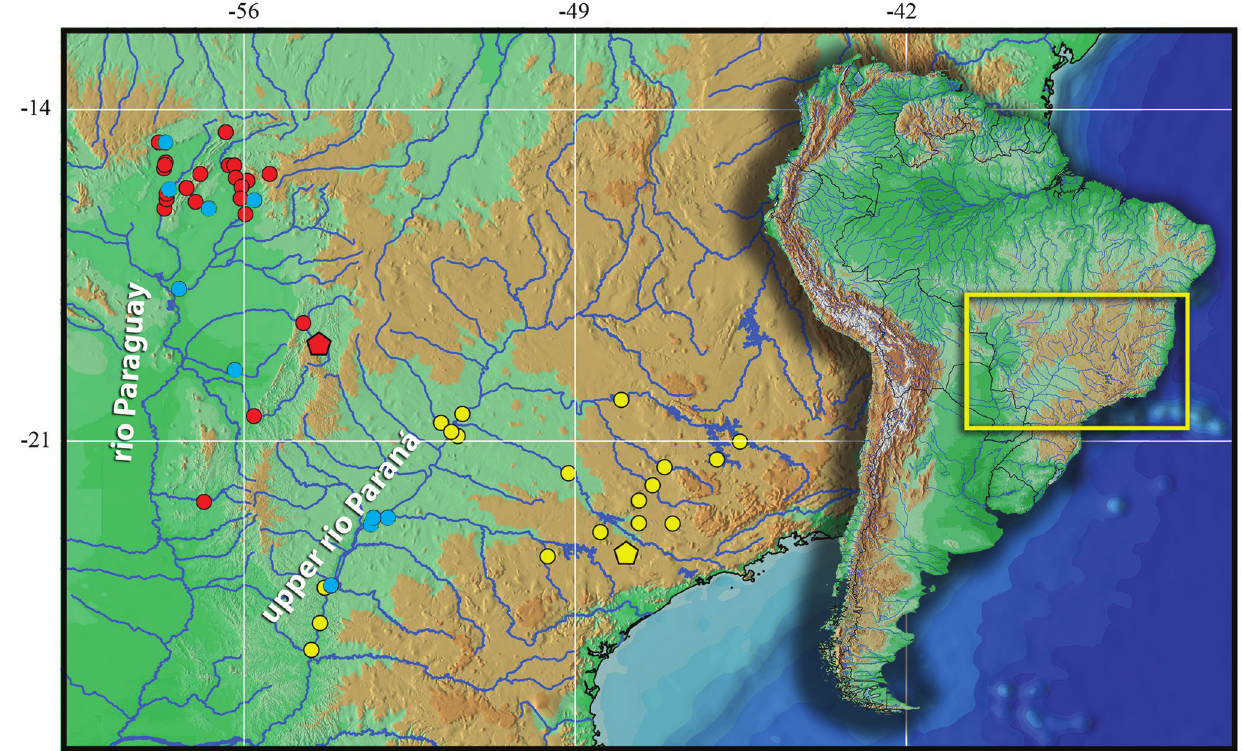
Fig. 5. Distribution map of Steindachnerina brevipinna in both rio Paraná and rio Paraguai (green), S. nigrotaenia in the rio Paraguai (red), and S. insculpta in the upper rio Paraná (yellow). Pentagons indicate type localities. Some symbols represent more than one collecting